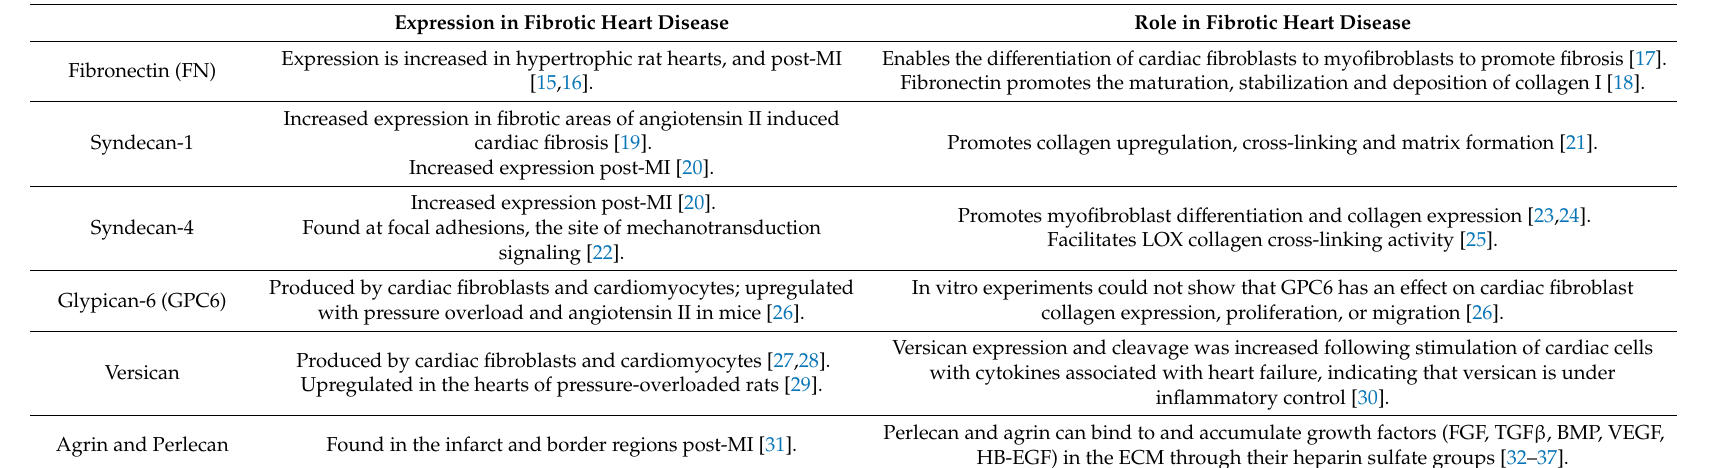
Table 2. Non-fibrillar ECM proteins that contribute to myocardial